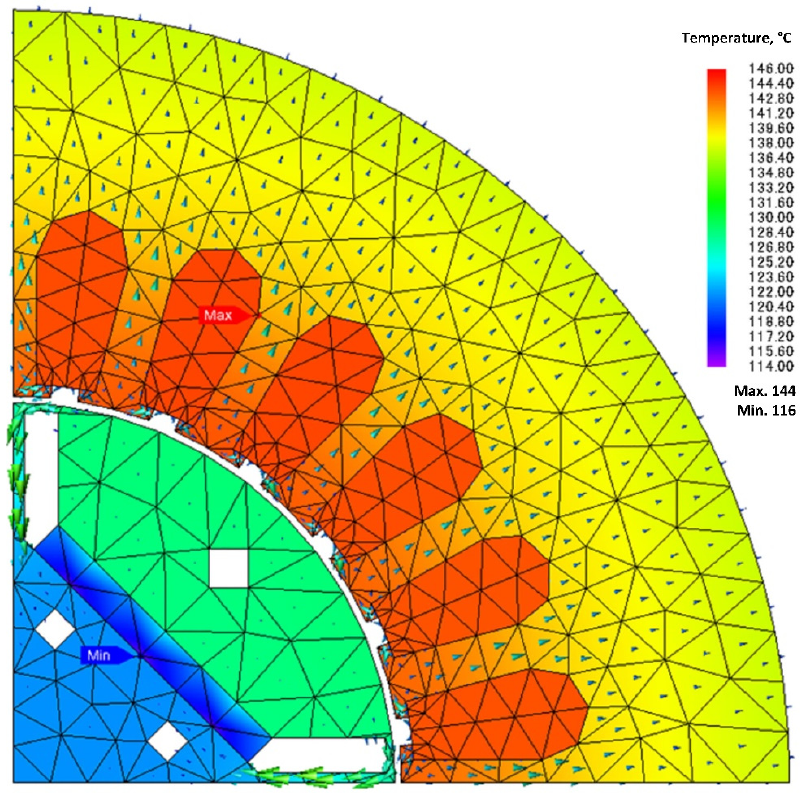
Figure 4. Partial FEA model of thermal analysis [10].